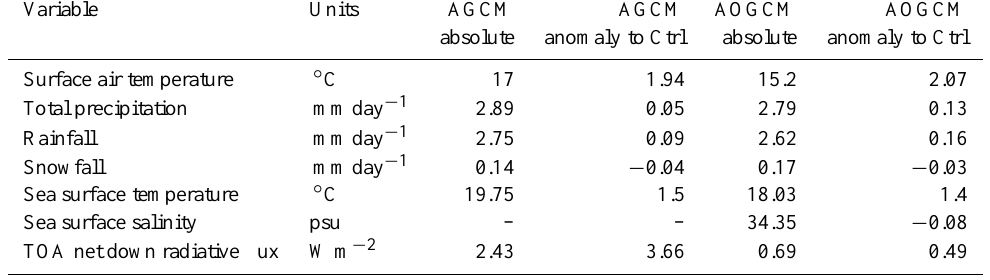
Table 2. Comparative table of global mean values for the AGCM and AOGCM mid-Pliocene simulations.